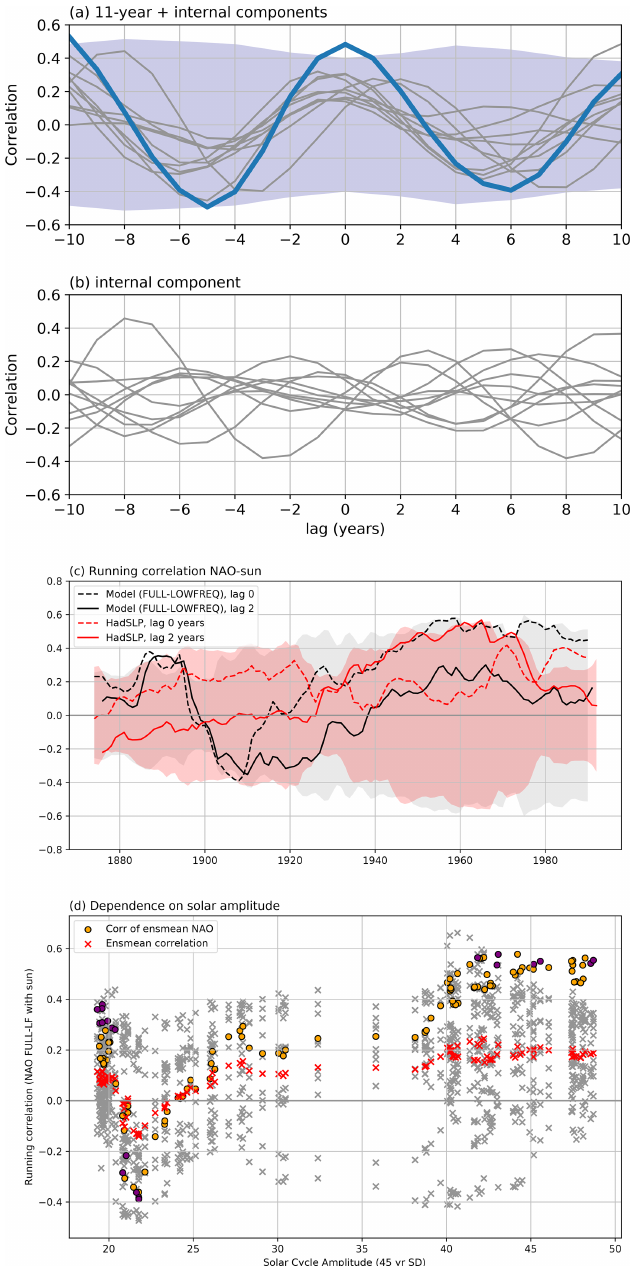
Figure 5. Synchronization of internal variability modes in the Atlantic with the solar cycle. Cross-correlation between the wintertime (DJF) solar index (F10.7 solar flux) and the February NAO-like station-based indices for (a) 11-year + internal components (FULL minus ensemble mean of LOWFREQ) and (b) internal component (FULL minus ensemble mean of FULL) during the strong epoch (gray thin lines: individual members; blue line: ensemble mean). The 90% significance level is shown as a shaded envelope (light blue). (c) The 45-year running correlation of NAO indices in February from the model (black lines; differences of the ensemble mean NAO indices as explained in the “Methods” section) and observation (red solid (lag 2 years) and red dashed (lag 0 years) lines) with the F10.7 index. The year on the x axis denotes the central year of the window (in the case of the lagged time series it is with respect to the NAO index). All indices are station-based and smoothed with a 3-year running mean prior to calculating the correlation. The 90% significance level is shown as shaded envelopes, for model (gray) and observations (light red) separately. (d) Scatterplot of February NAO–Sun running correlations (FULL–LOWFREQ, smoothed with 3-year running mean, 45-year windows; similar to Fig. 5c) against solar cycle amplitude (standard deviation of smoothed F10.7 time series, same 45-year windows). Red crosses are the ensemble mean of correlations of single ensemble members with the solar index. Dots are the correlation of the ensemble mean NAO with the solar index; purple dots are correlations that exceed the 90% significance level calculated with a random-phase